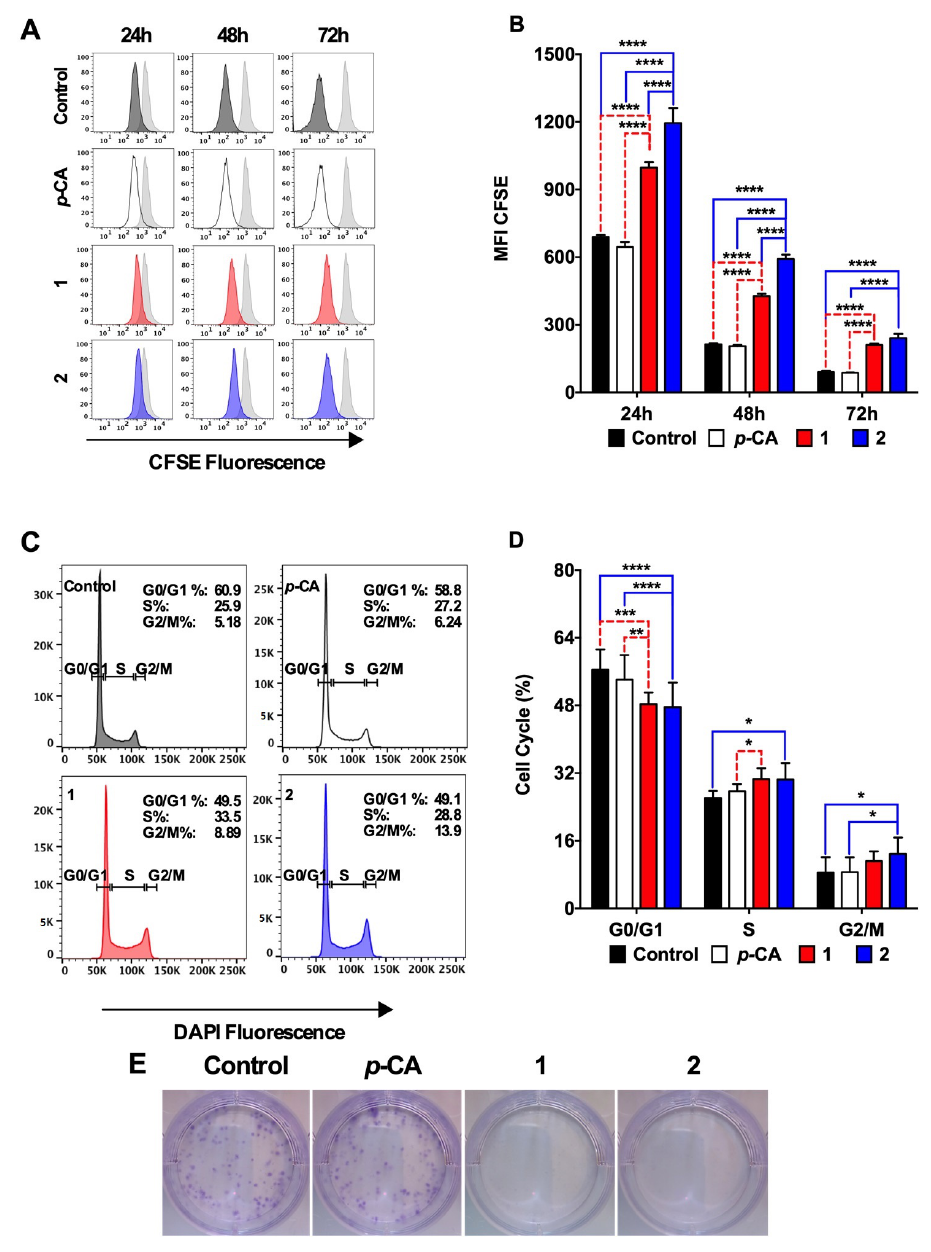
Figure 4. Ethyl p -coumarate ( 1 ) and n -Butyl p -coumarate ( 2 ) inhibits the SK-MEL-25 cell proliferation and induces the cell cycle arrest at the S and G2/M phases. Human SK-MEL-25 melanoma cells were incubated with p -coumaric acid ( p -CA, white), ethyl p -coumarate ( 1 , red) or n -butyl p -coumarate ( 2 , blue) at 0.1 mM. ( A , B ) cells were cultured for 24, 48, and 72 h in the presence of the compounds and stained with CFSE to determine the cell proliferation over 72 h; ( C , D ) cells were cultured for 24 h in the presence of the compounds and stained with DAPI to analyze the cell cycle profile; ( E ) cells were cultured for 72 h in the presence of compounds and cultured for an additional seven days in a fresh medium to determine their capacity to form cell colonies. This figure represents a single sample from n = 3/group of the two independent experiments. Control cells were incubated with the concentration of DMSO equivalent to those at 0.1 mM of the compounds. * p < 0.05, ** p < 0.01; *** p < 0.001, **** p <